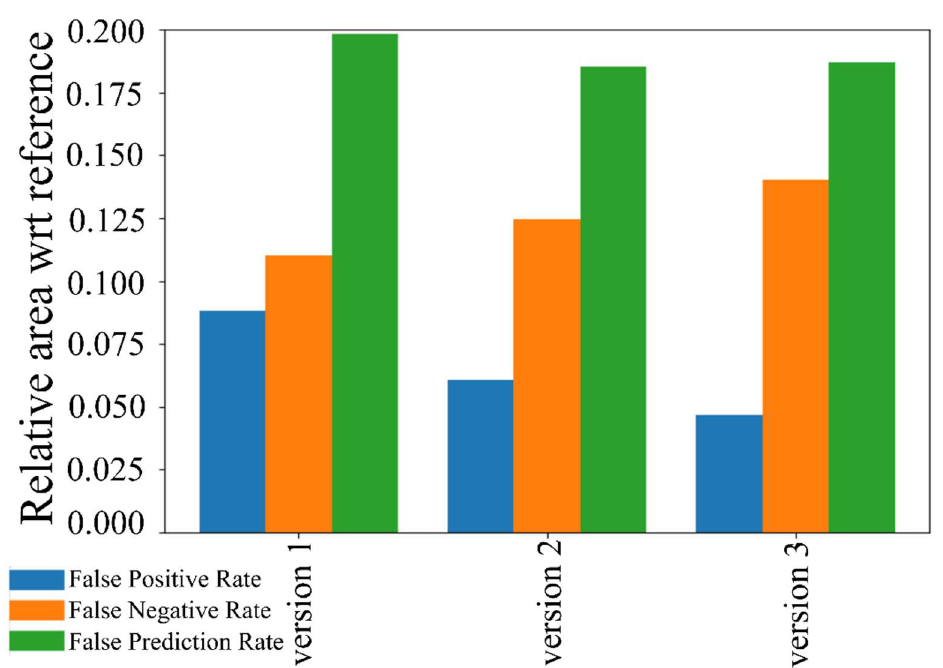
Figure 8. Comparison of the three ensembled polygon versions to the corrected shapefile of the 2013 (July 14) test scene. False positive rate = a lake polygon was predicted where no lake exists. False negative rate = no lake polygon was predicted where a lake exists. False prediction rate = sum of false positive rate and false negative rate. (‘wrt’ = with respect to).